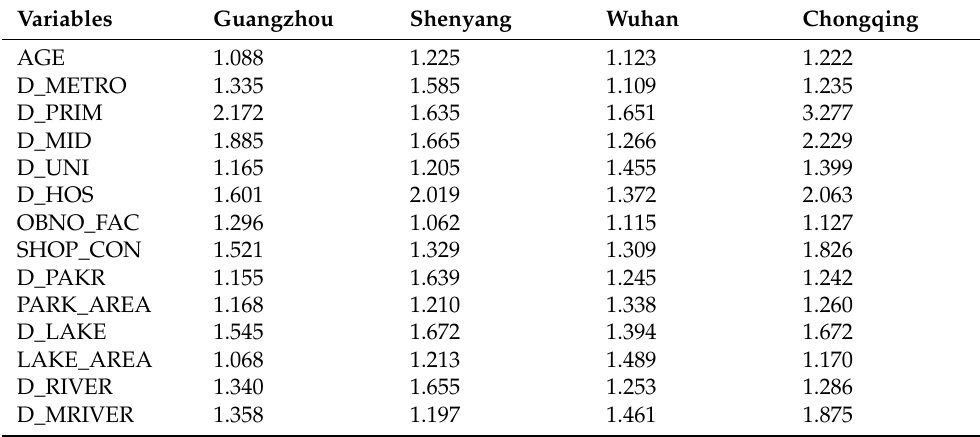
Table A12. VIFs for Model II.